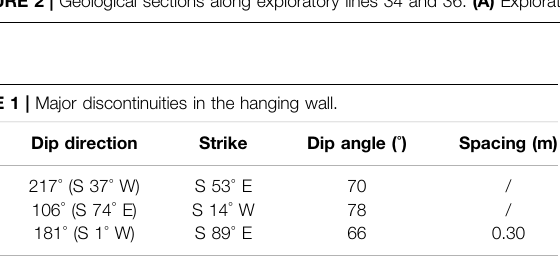
FIGURE 2 | Geological sections along exploratory lines 34 and 36. (A) Exploratory line 34. (B) Exploratory line 36.